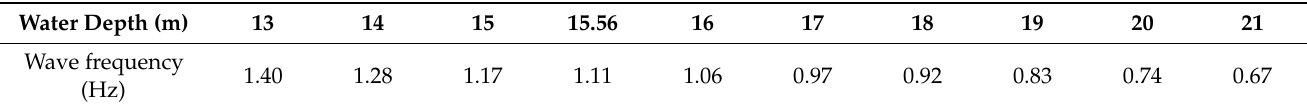
Figure 17. The fast Fourier transform (FFT) of pressure time − series at the monitoring boundary points for Wenchuan seismic excitation at different water depths. Table 5. The frequency of the inner water waves for Wenchuan seismic excitation at different water depths.